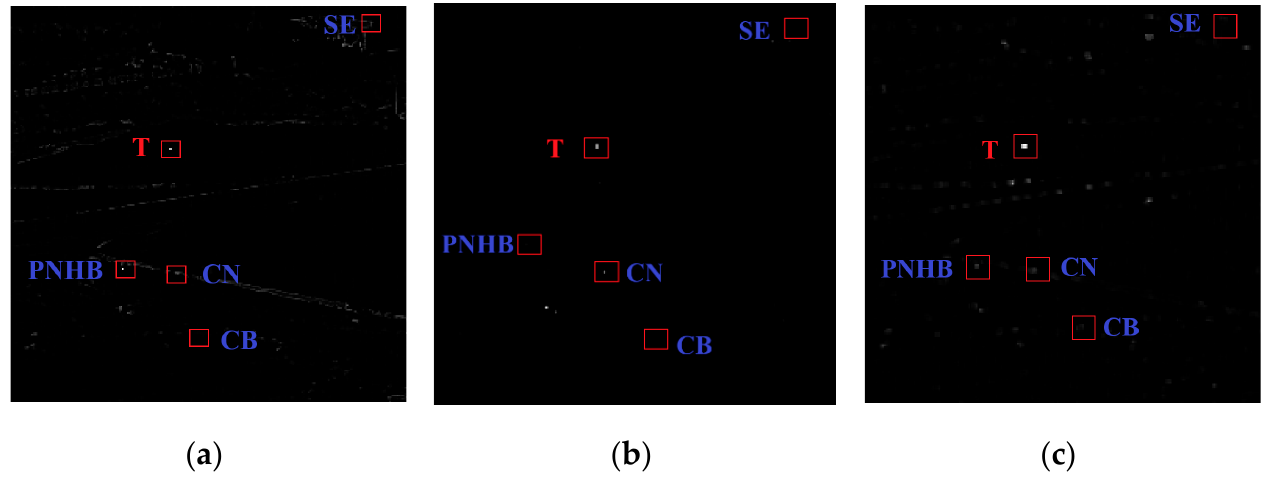
Figure 4. Detection stage maps. ( a ) Preprocessing results map. ( b ) BSM salient map. ( c ) LCV salient map.